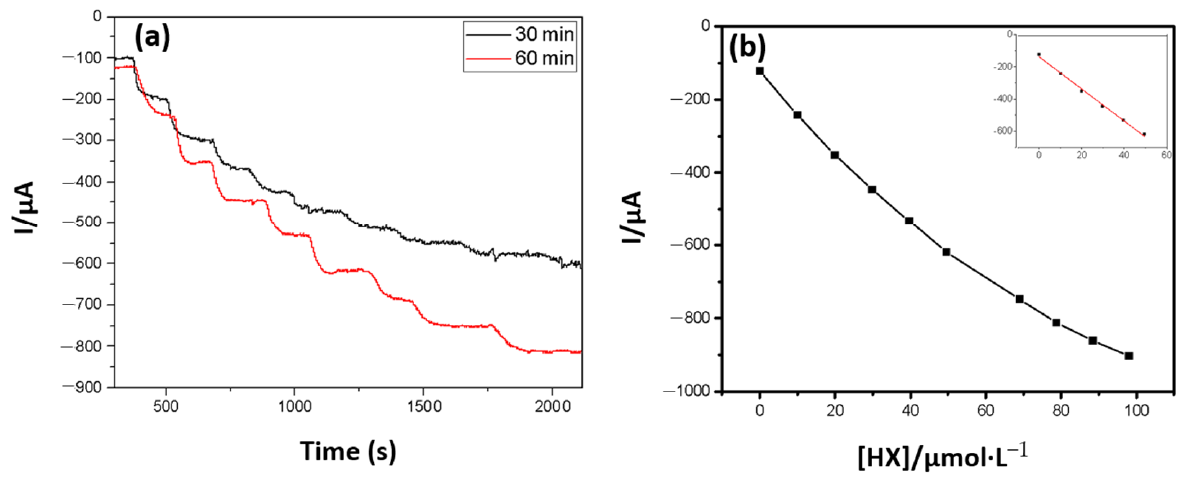
Figure 4. ( a ) Response of the amperometric biosensor with the successive addition of HX under constant agitation of 300 rpm, with the PB as a mediator and 8 mU of immobilized enzyme load, with polymerization times of 30 and 60 min. E = − 100 mV. ( b ) Calibration curve of the amperometric biosensor modified with PB, when polymerization time of 60 min is